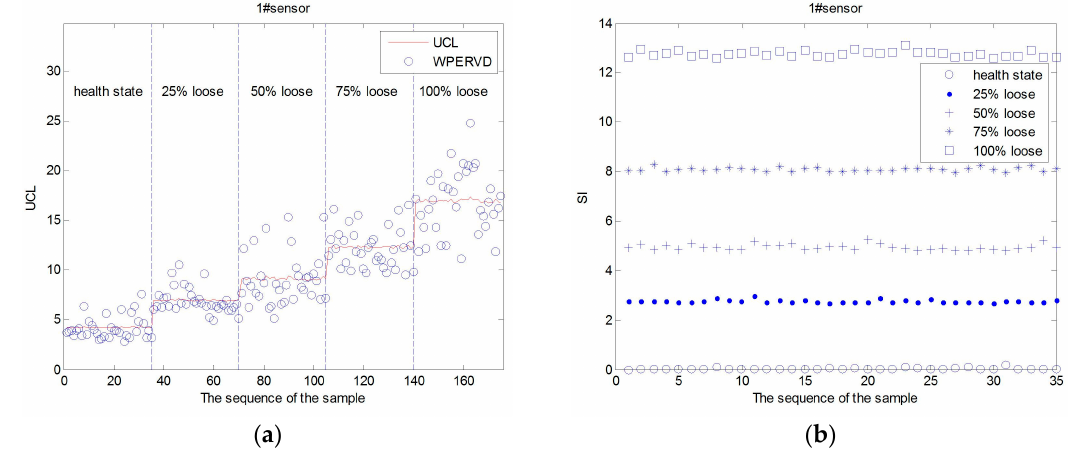
Figure 7. The UCL , WPERVD and SI distribution of sensor #1. ( a ) The UCL and WPERVD distribution of #1 sensor; and ( b ) the SI distribution of sensor #1.